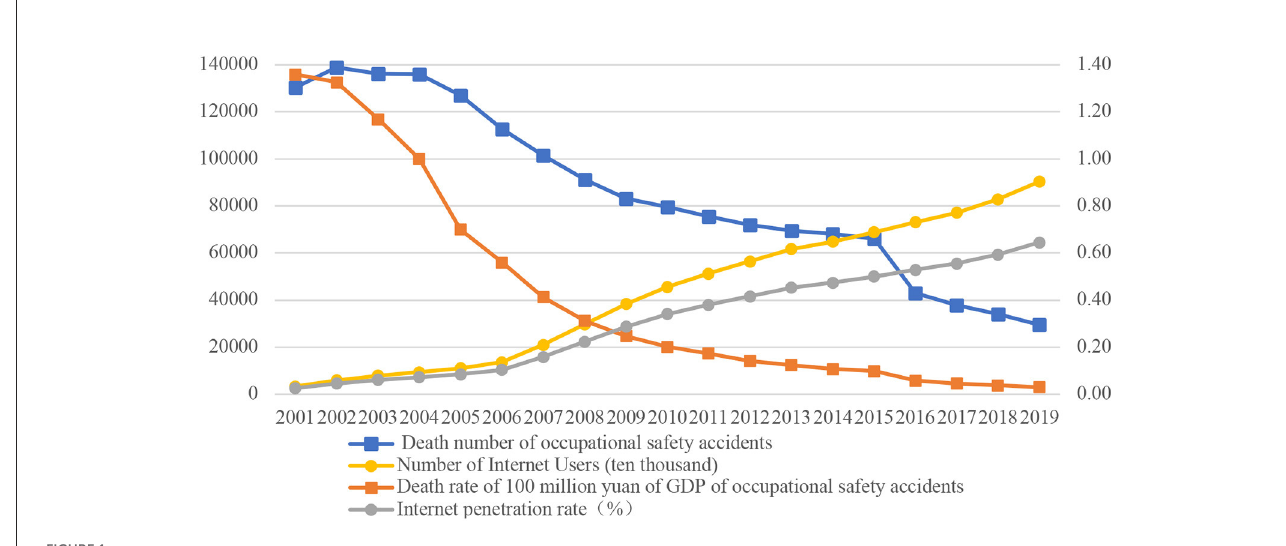
FIGURE1 The correlationship between occupational safety accidents and internet penetration